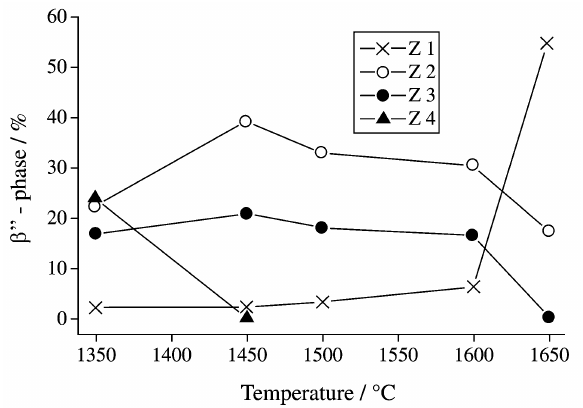
Figure 7. Evolution of the β ” phase with temperature and carbon content. (Reaction time: 120